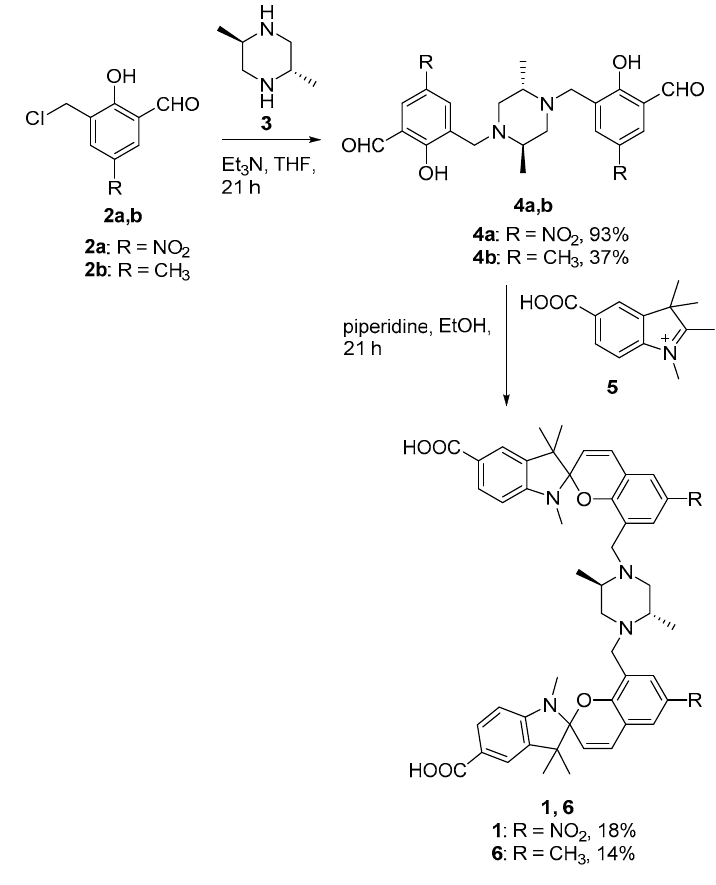
Figure 2. Synthesis of analogues 1 and 6 .